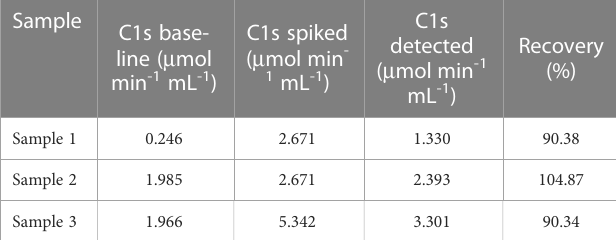
TABLE 2 Relative recovery of C1s obtained from human serum samples spiked with C1s of different activities.